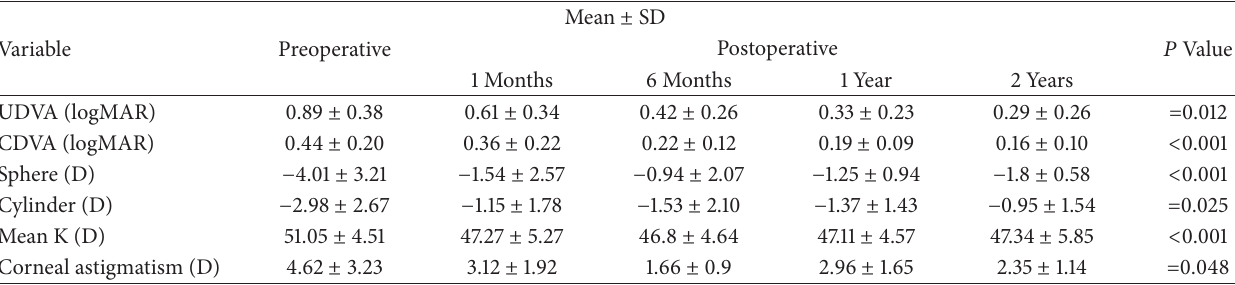
Table 1: Visual and refractive outcomes over